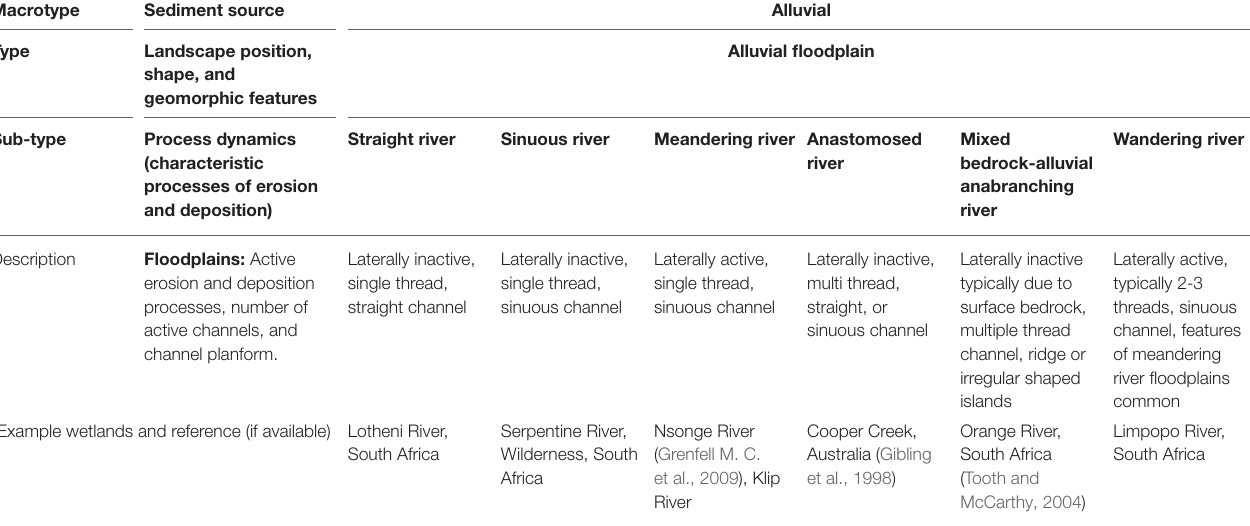
TABLE 3 | Description of floodplain